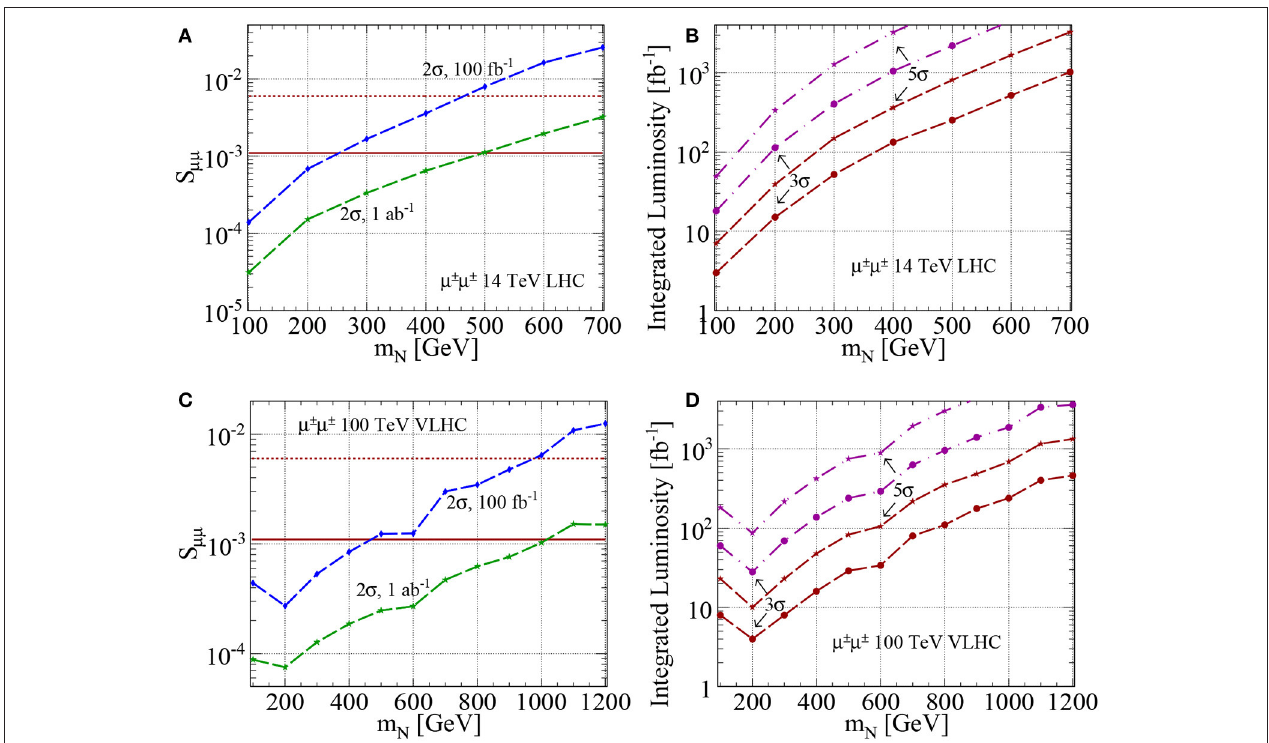
X process. (B) The required luminosity for a 3 (dash-circle) and 5 σ µ ± µ ± for the pp ℓℓ ′ → +